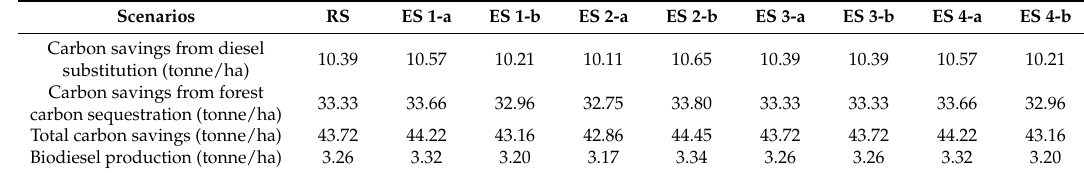
Table A4. Annual biodiesel production and total carbon savings of RS and ESs